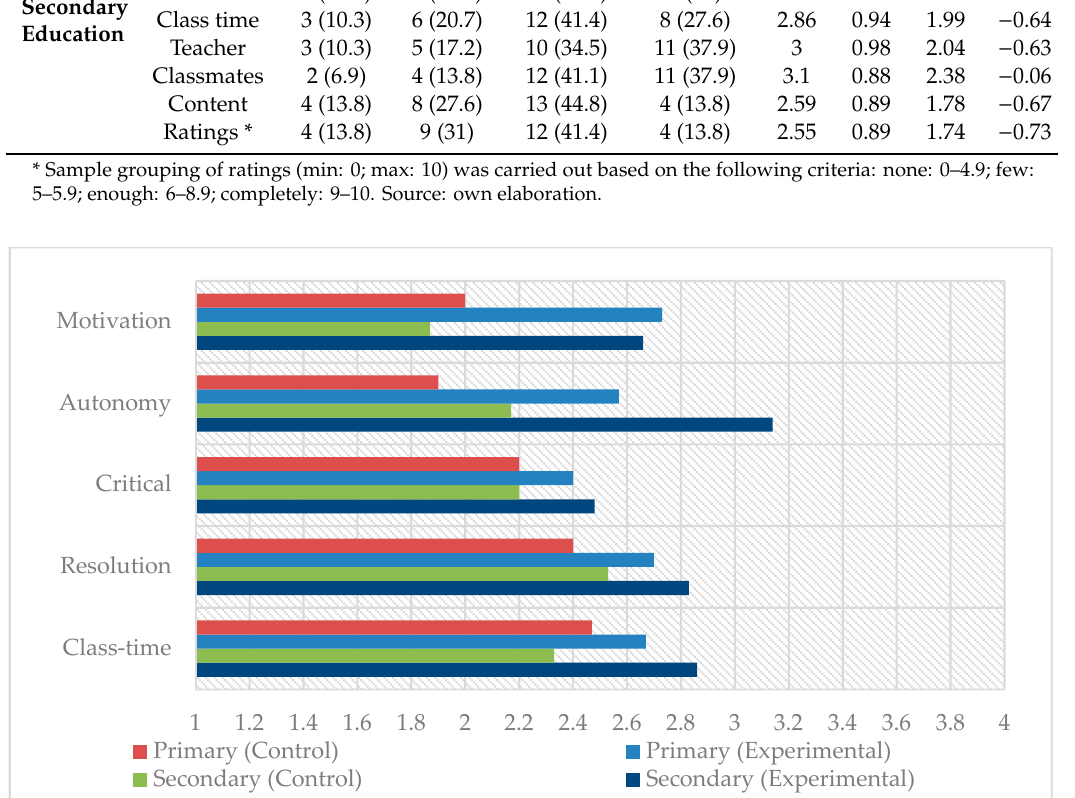
Figure 2. Intergroup comparison in interactive dimension. To determine the value of independence between the results obtained for the traditional approach and flipped learning, Student’s t-test was carried out (Table 6). A standardized value of p < 0.05 was considered a statistically significant difference. As a corrective element for d (correlation force), a distinction for bi-serial correlation ( r = [0, 1]) was made between small ( r = − 0.1), medium ( r = − 0.3), and large ( r = − 0.5) effect size. It has been proven that the flipped learning approach in physical education causes a significant improvement in the interaction of students with teachers and peers. In both primary education ( r = − 0.57, r = − 0.62) and secondary education ( r = 0.63, r = − 0.6), the results confirm an acceptable strength of association. Statistical significance was also obtained in the variables related to motivation and